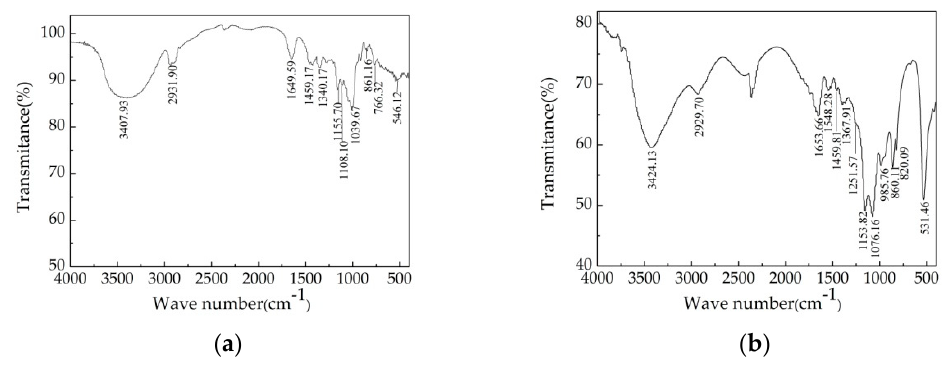
Figure 5. Fourier-Transform Infrared (FT-IR) spectra of Dextran T-500 ( a ) and P-IIa ( b ).